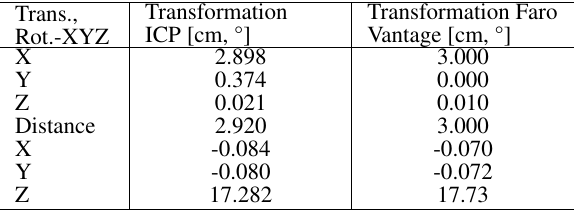
Table 1. Transformation value results from small scale testing, comparison between ICP and external measurement.